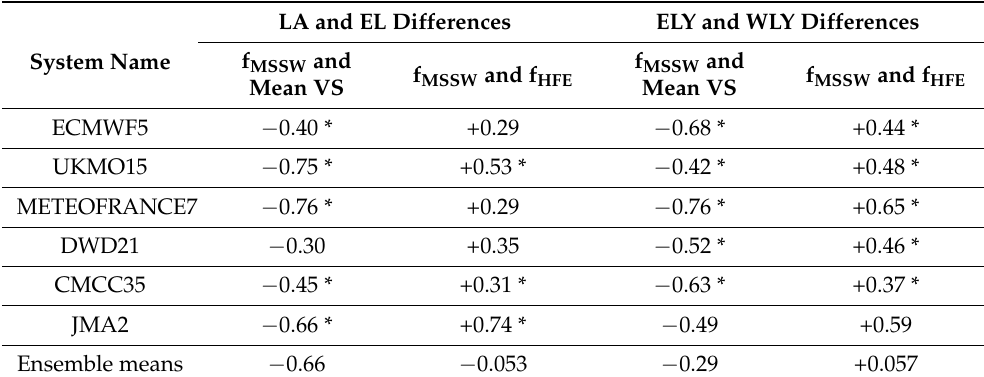
Figure 13. ( a ) Similar to Figure 6a, but for EL minus LA differences. Panel ( b ) is similar to ( a ), but use the HFE frequency instead of the mean VS. Panels ( c , d ) are similar, but for WLY minus ELY differences. Table 3. Same as Table 2, but for differences between LA and EL, and between ELY and WLY. Asterisk denotes statistical significance at the 95% level.